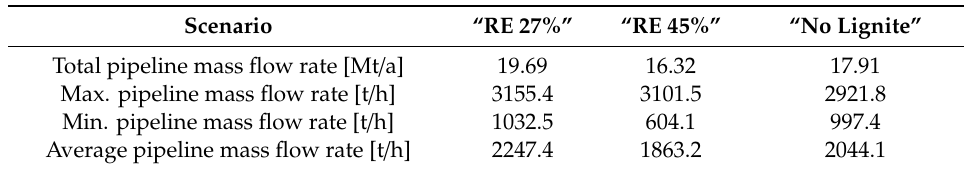
Table 3. Pipeline mass flow rates (total, minimum, maximum, average) in the scenarios “RE 27%” (baseline), “RE 45%” and “No